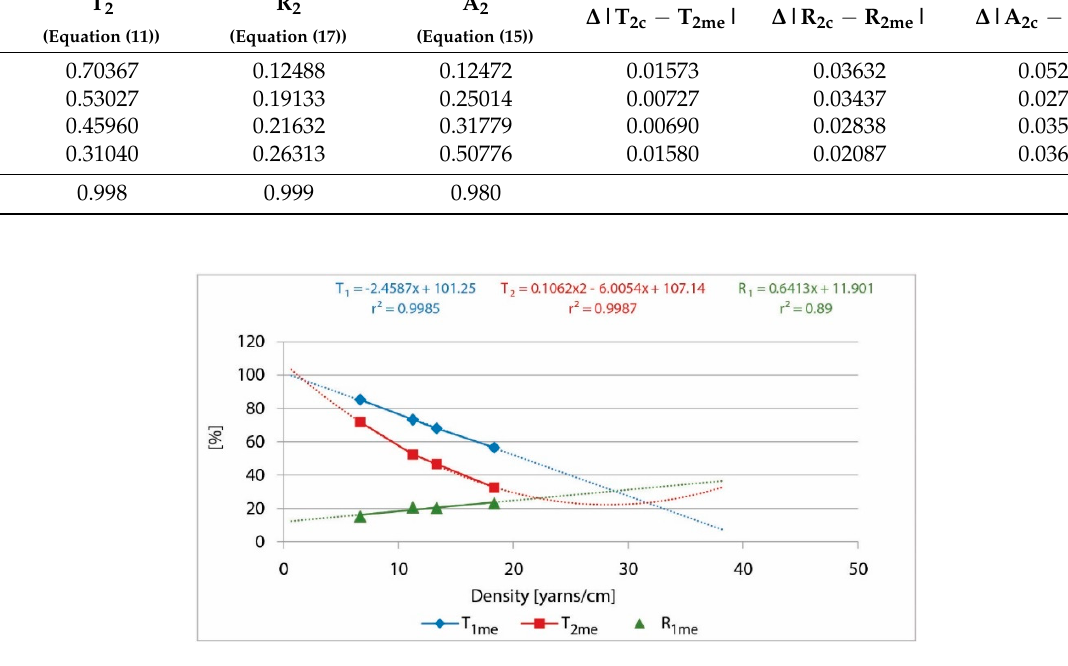
Figure 8. T and R of UV radiation of single-layer and double-layer PET samples, depending on the yarn density, with the corresponding linear, polynomial equations, and the coefficient of determina-